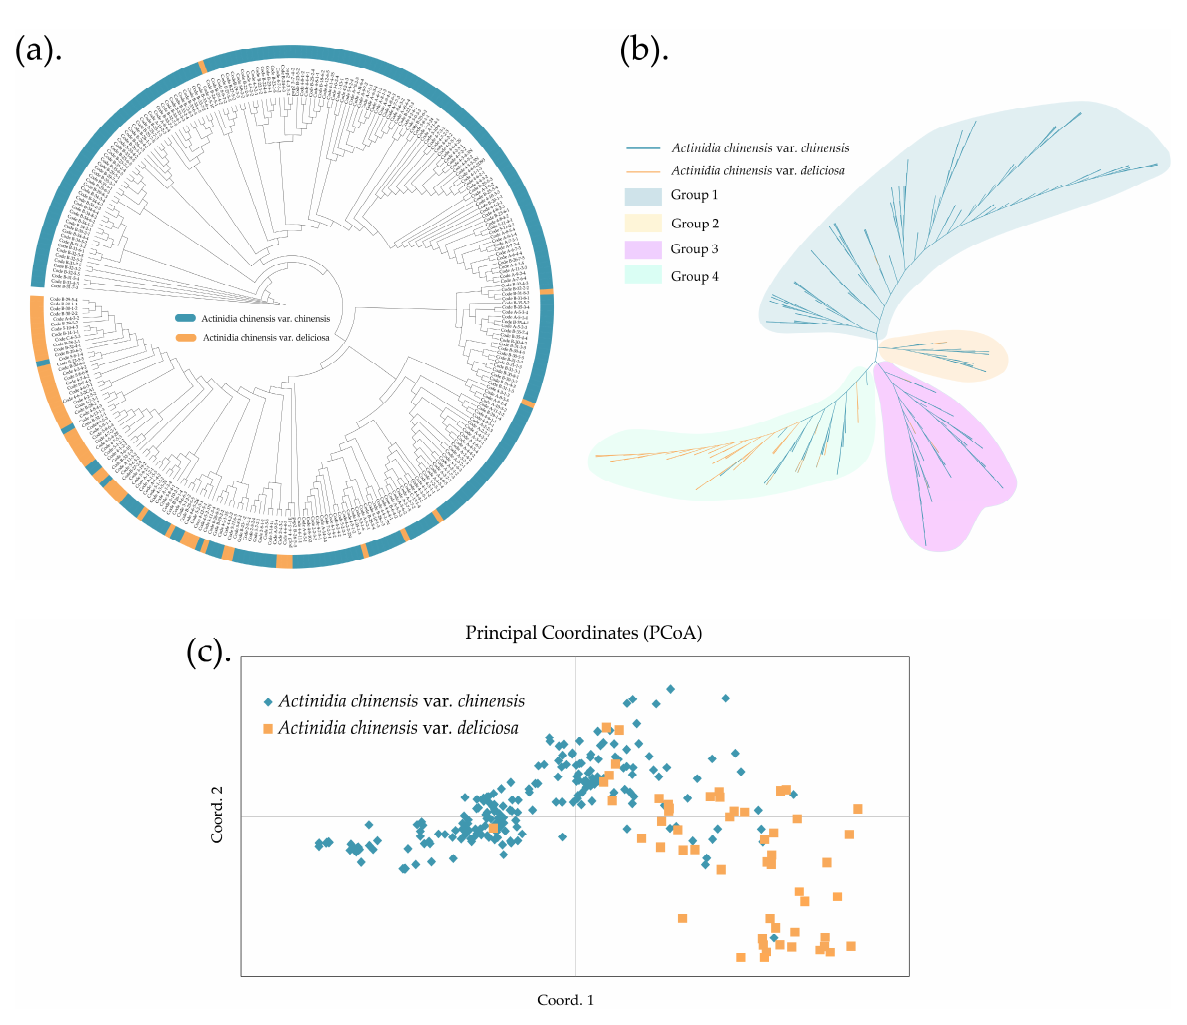
Figure 1. Cluster analysis of the A. chinensis complex. ( a ) Rooted cluster map. ( b ) Unrooted cluster map. ( c ) Principal coordinate analysis.